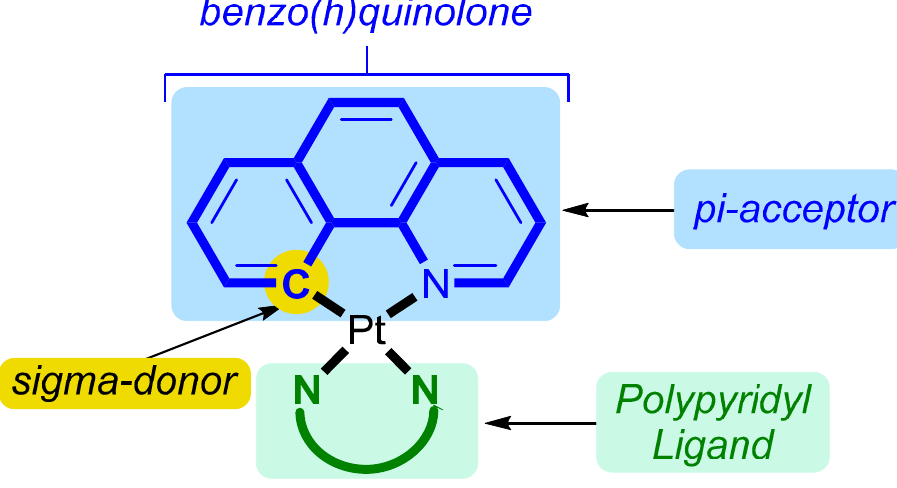
Figure 1. General structure of cyclometallated ligand benzo(h)quinoline CMCs.